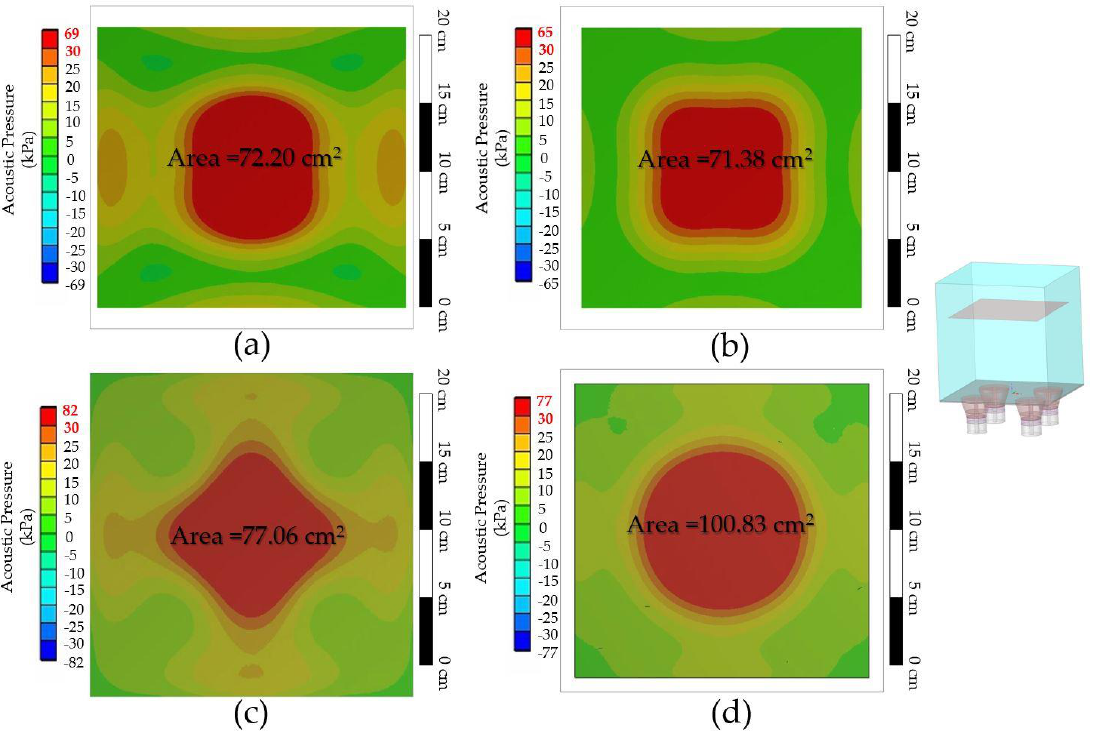
Figure 8. Acoustic pressure distribution in horizontal plane of ( a ) model A, ( b ) model B, ( c ) model C, and (d) model D.